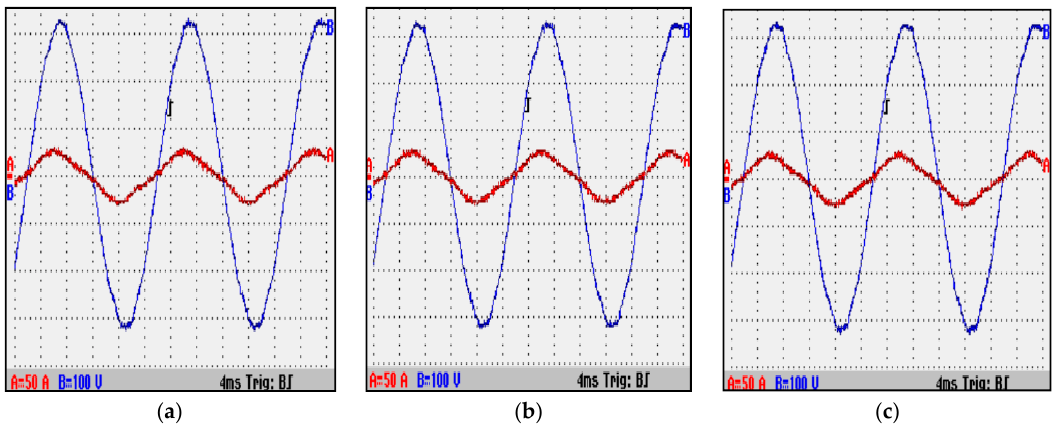
Figure 25. Current and voltage supplied to a 24 kWh electric vehicle at various SoC. ( a ) SoC = 17%; ( b ) SoC = 31%; ( c ) SoC = 42%.